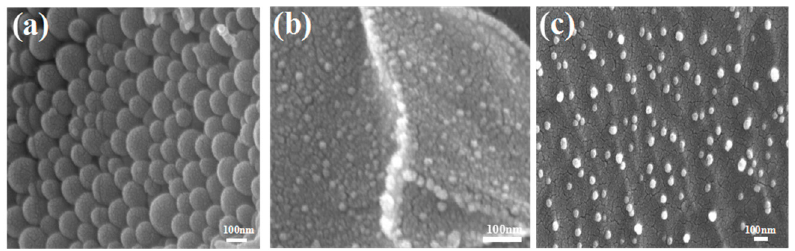
Figure 6. Cryo-SEM images of S1 ( a ), S2 ( b ) and S3 ( c ).